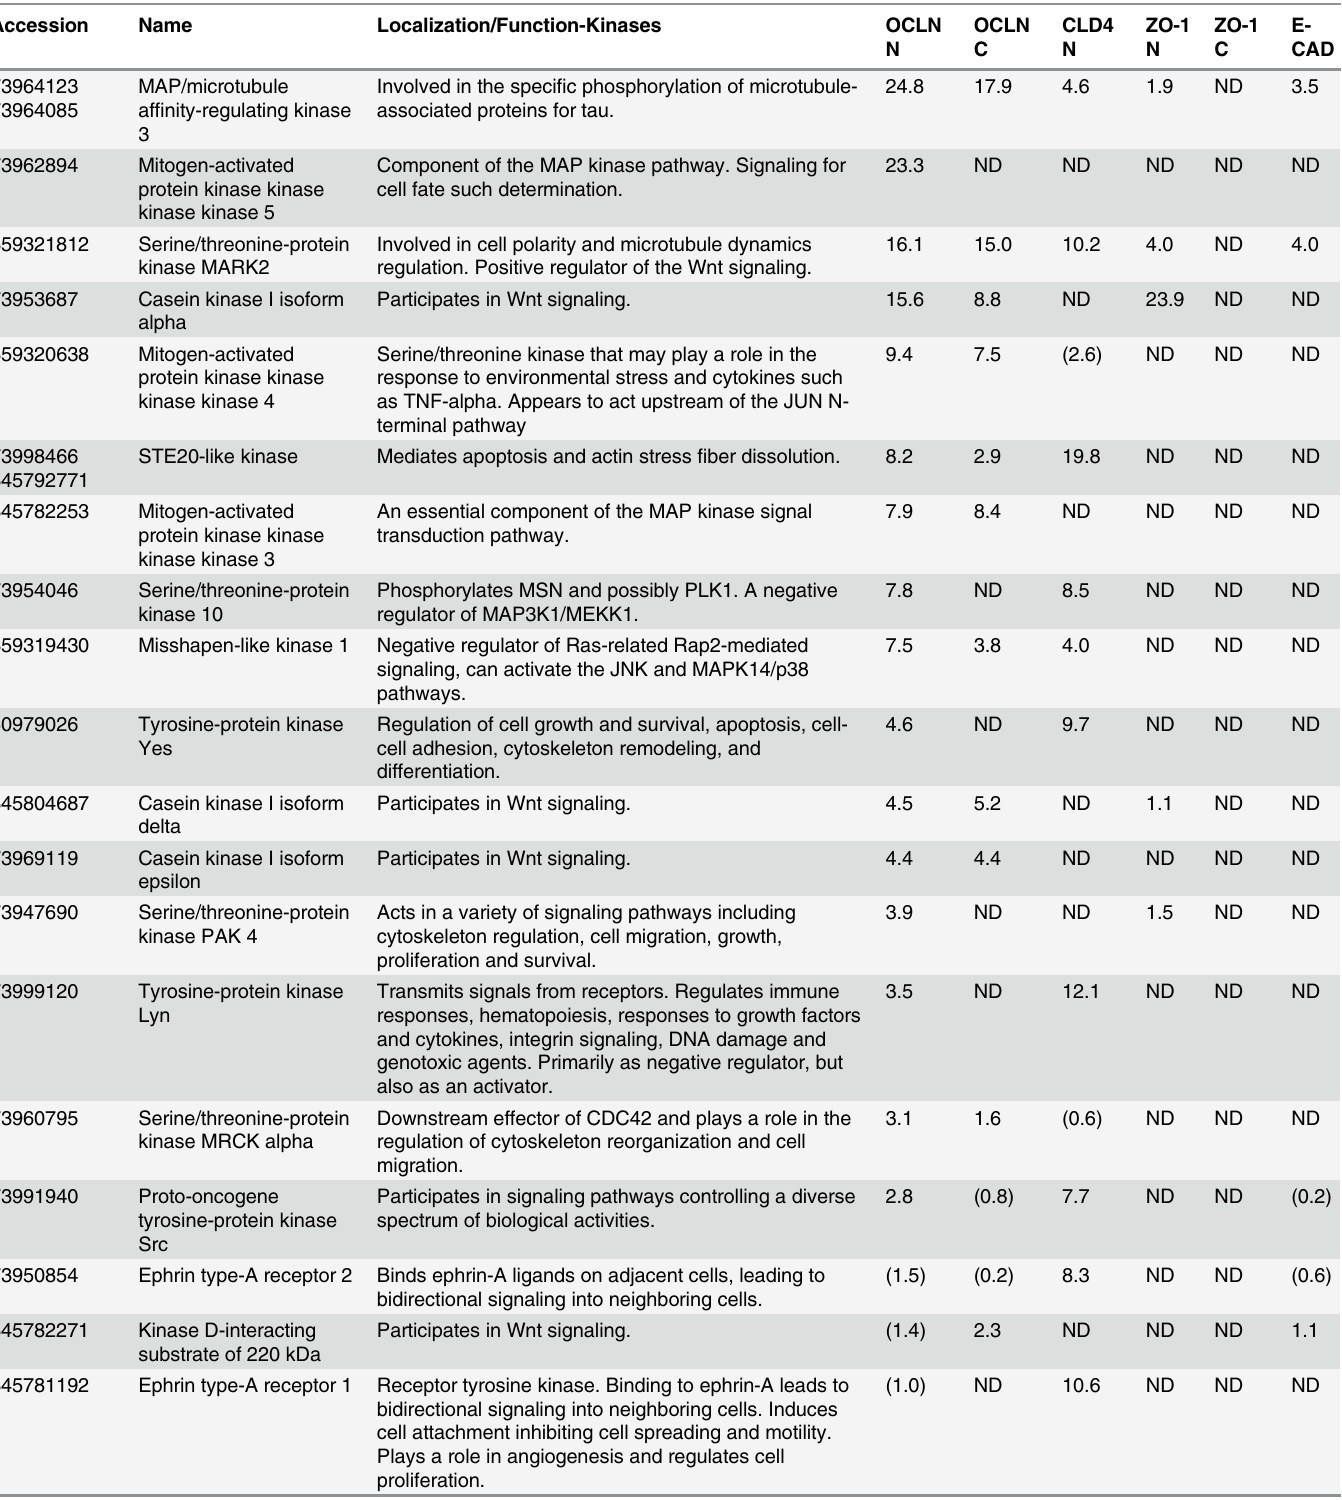
Table 3. Enriched kinases and phosphatases tagged by biotin ligase fused to occludin and claudin-4.